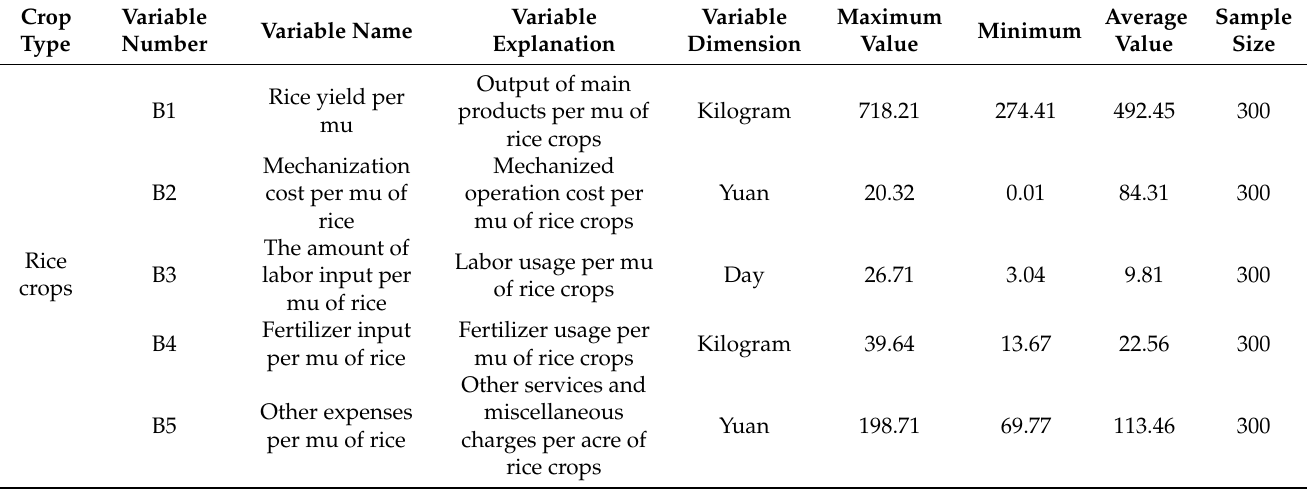
Table 2. Data variables of crop yield per unit